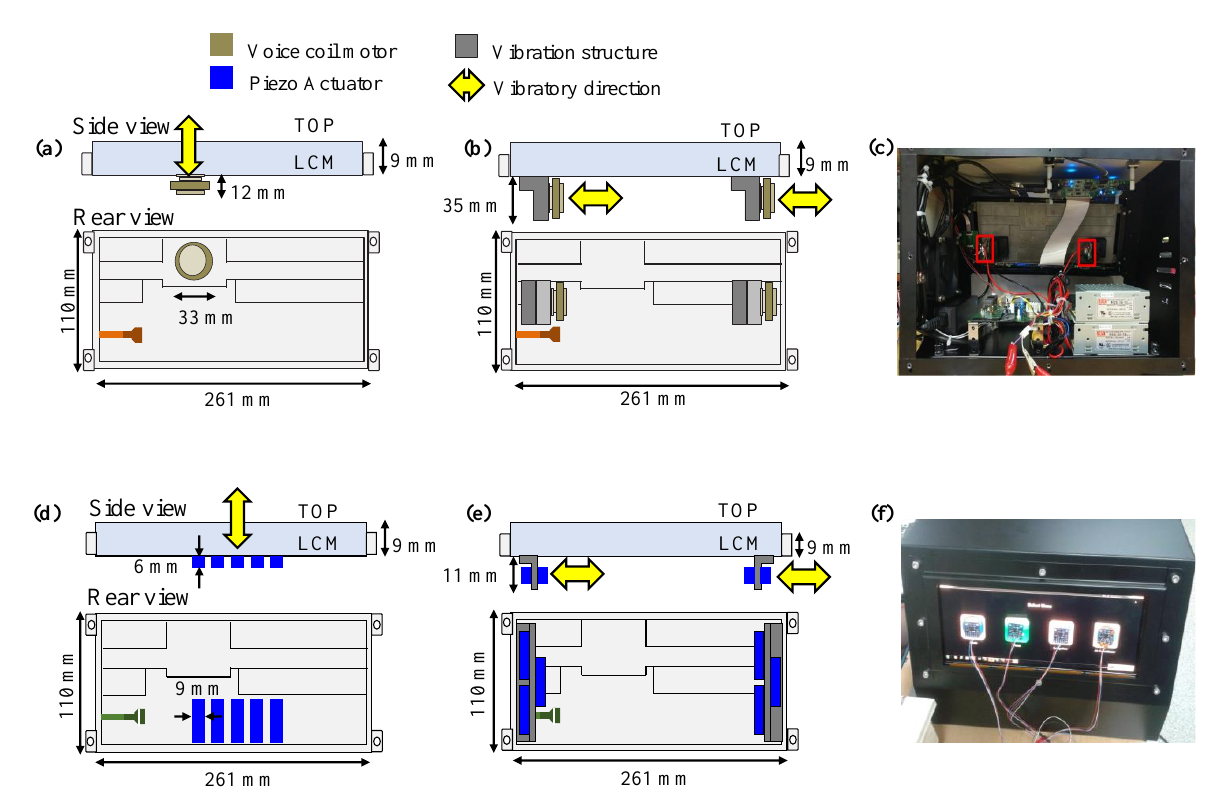
Figure 9. Overview of the haptic systems implemented for automotive touch screens. ( a ) Vibration in the normal direction